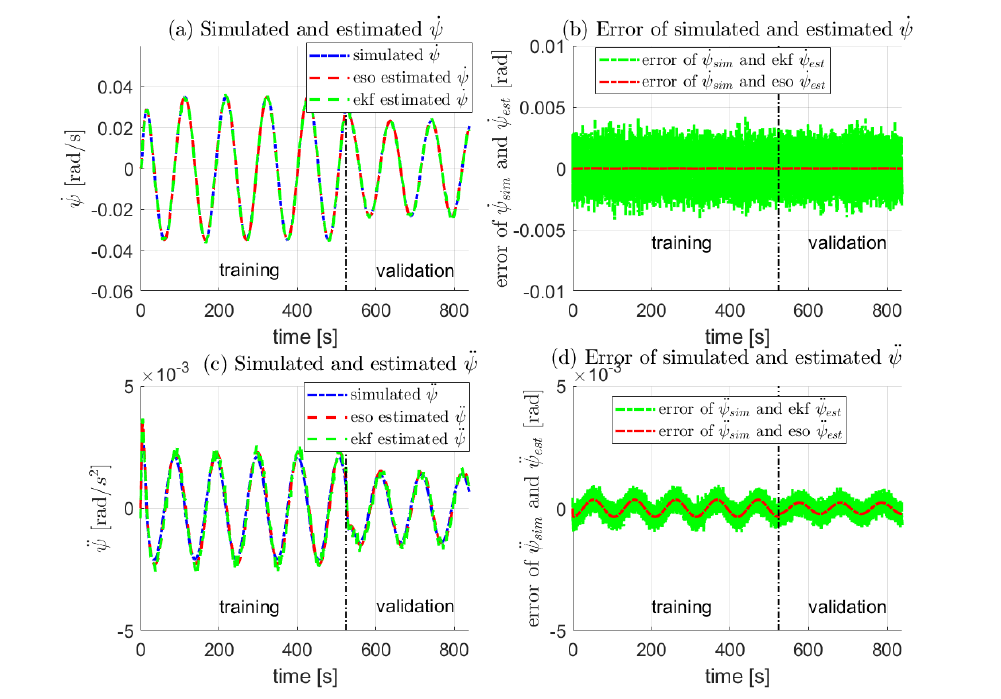
Figure 6. Estimated states of the patrol vessel. The data on the left side of the black dotted line are training samples and on the right side are validation